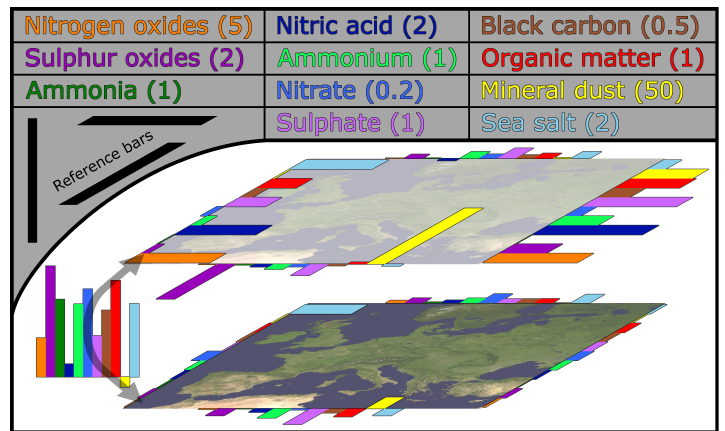
Fig. 6. Transport diagram showing fluxes from north, east, south and west for the boundary layer and the free atmosphere; and the exchange between the two layers. These values are net fluxes integrated over the year 2006. The legend at the top maps the colours to the tracers and defines the value (in Tgyr − 1 ) to which the black reference bars at the upper left corner correspond. Nitrogen oxides include NO, NO 2 , Peroxyacytyl nitrate (PAN), NO 3 , HNO 4 and N 2 O 5 , but no nitric acid or aerosol nitrate. Sulphur oxides include SO 2 and H 2 SO 4 , but no aerosol sulphate. Nitrogen compounds are expressed as masses N, sulphur compounds as masses S and sea salt as masses Na. For black- and-white print: the bars represent from left to right (for east/west transport from bottom to top): nitrogen oxides, sulphur oxides, ammonia, nitric acid, ammonium, nitrate, sulphate, black carbon, organic matter, mineral dust and sea salt.